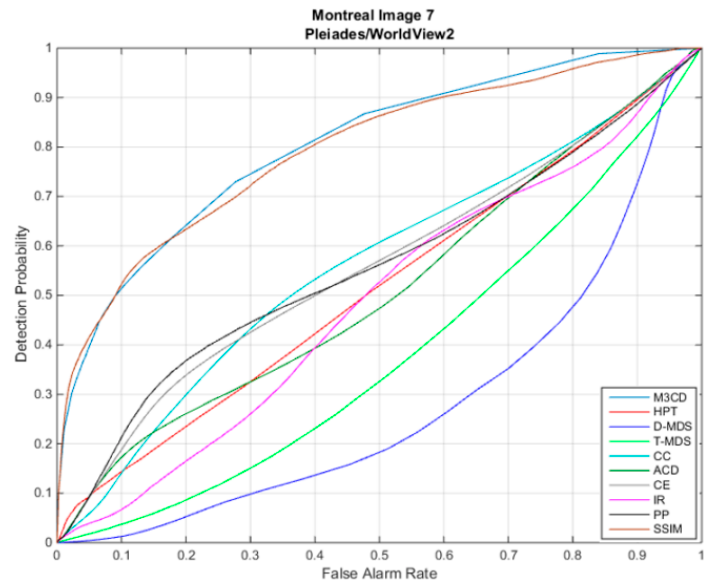
Figure 19. ROC curves for Image Pair-5 without EMAP.